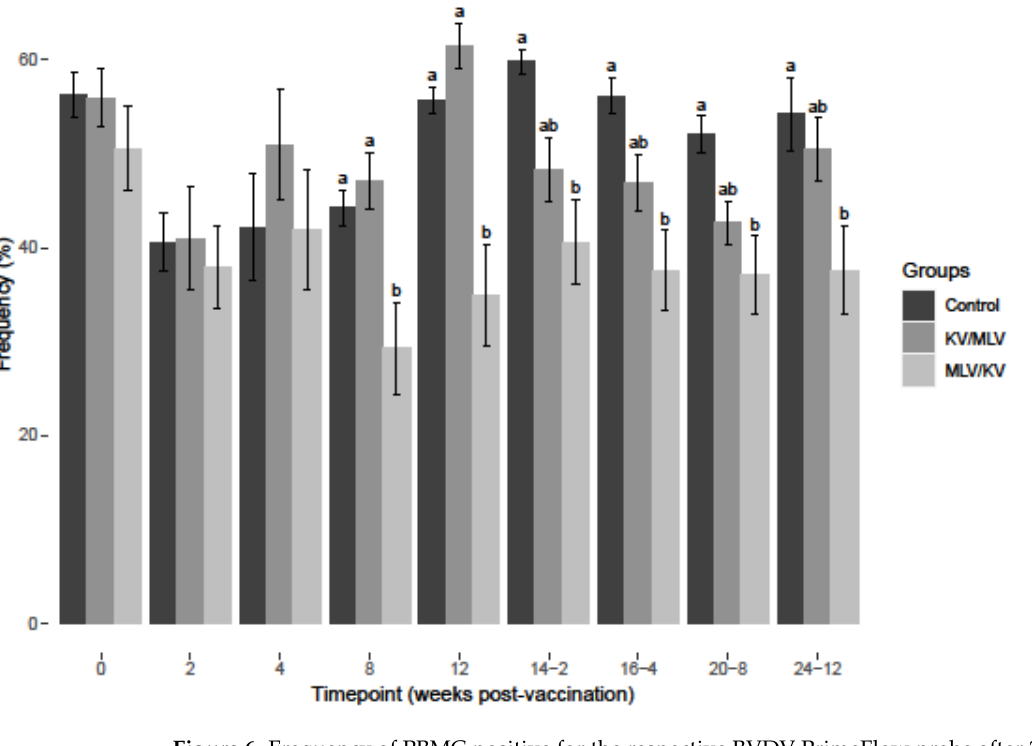
Figure 6. Frequency of PBMC positive for the respective BVDV PrimeFlow probe after 24-hour stim- ulation at each respective timepoint over the course of the study with BVDV-2a (PI-28). Values at each timepoint, not connected by the same letter are significantly different ( p <